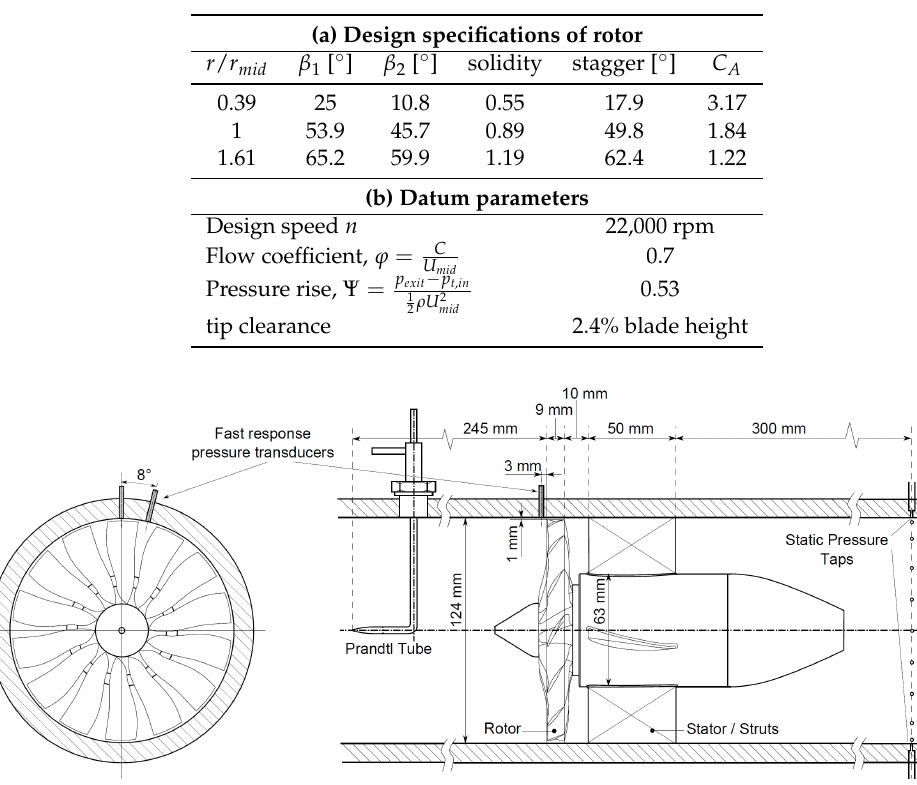
Table 1. Compressor design.